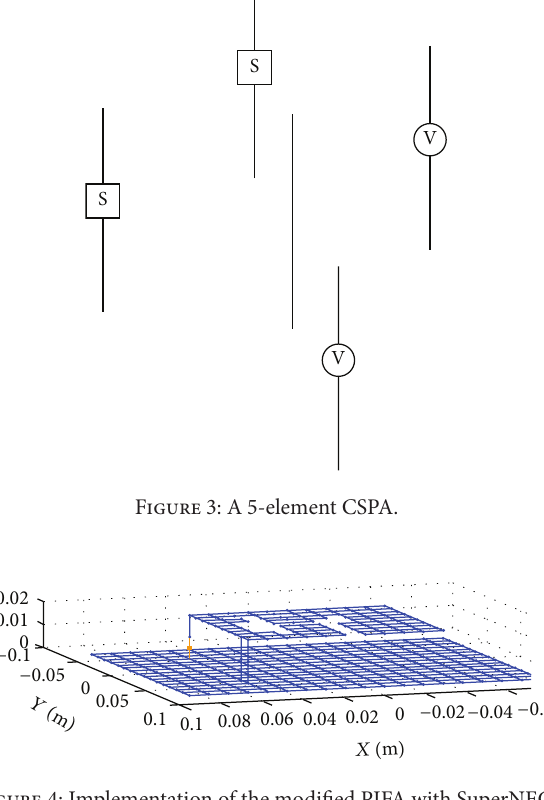
Figure 4: Implementation of the modified PIFA with SuperNEC.